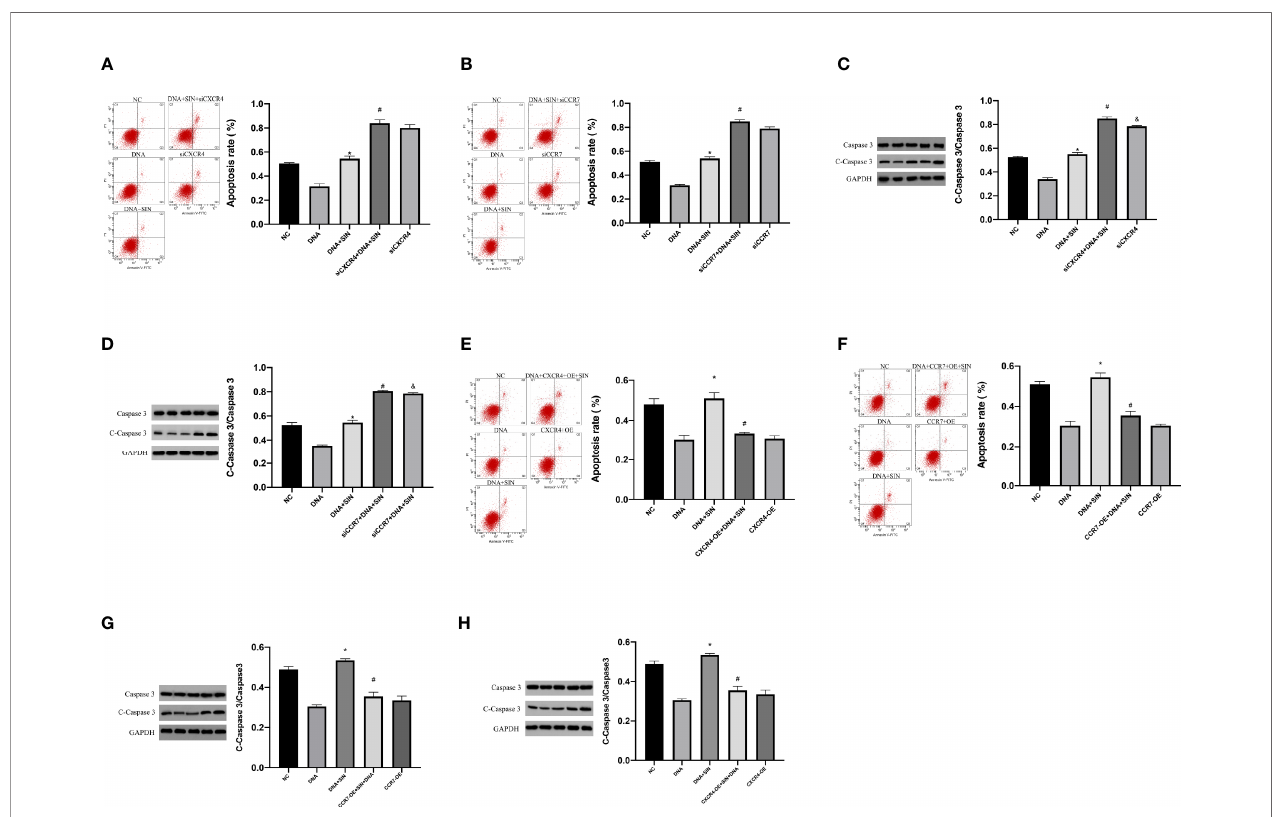
FIGURE 9 | Tumor-derived DNA reduces apoptosis in HCC cells via CXCL12-CXCR4 axis and CCL21-CCR7 axis, and sinomenine hydrochloride reverses the reduction in apoptosis. (A, B) Flow cytometry to identify the role of siCXCR4 or siCCR7 in the programmed cell death of SK-Hep1 cells in the presence of tumor- derived DNA. (C, D) WB assay to identify the expression of apoptotic protein in cells. (E, F) The effect of CXCR4 or CCR7 overexpression on the programmed cell death of SK-Hep1 cells in the presence of tumor-derived DNA was detected by fl ow cytometry. (G, H) WB assay to identify the expression of apoptotic protein in cells. *P <0.05(compared with NC), #P<0.05 (compared with DNA+SIN group), &P<0.05 (compared with siCXCR4+DNA+SIN, or compared with CXCR4-OE